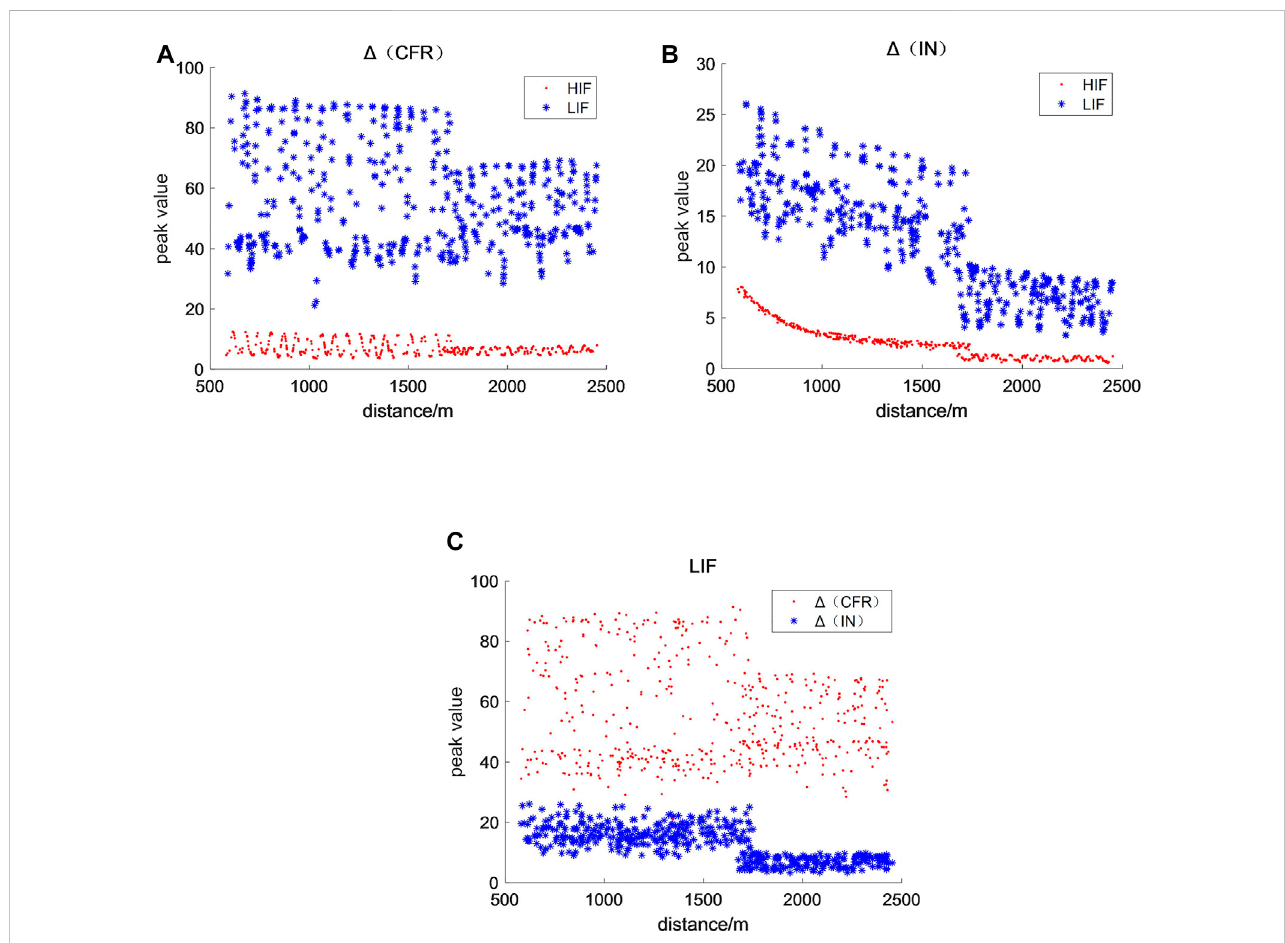
FIGURE 12 Comparison of 500 sets of Δ data. (A) is the Δ data comparison of CFR in the case of HIF and LIF. (B) is the Δ data comparison of IN in the case of HIF and LIF. (C) is the comparison of CFR and IN under LIF.